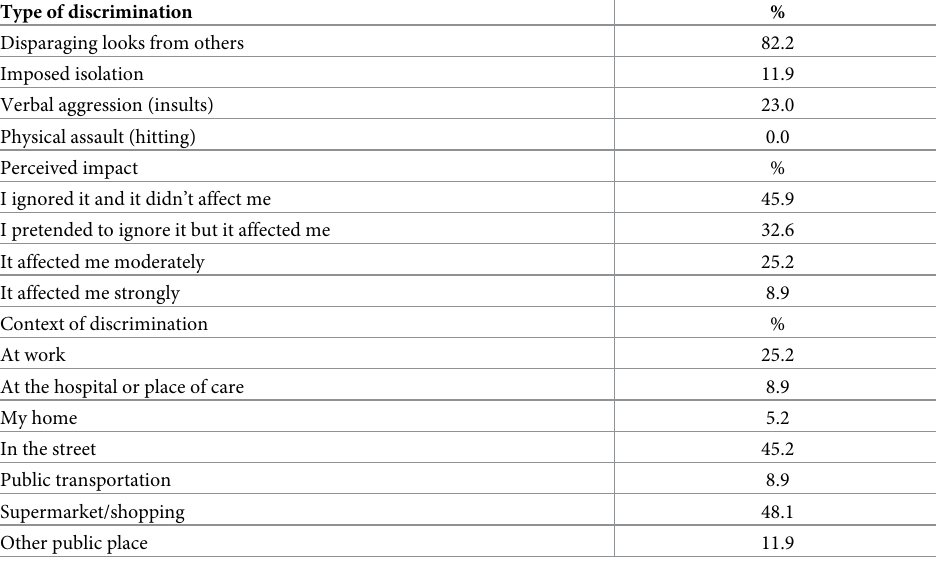
Table 2. Frequencies concerning type of discrimination, perceived impact and the context of discrimination (dis- crimination group only). Type of